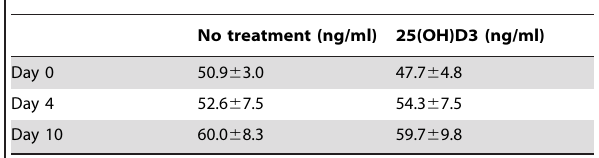
Table 1. Serum levels of 25(OH)D 3 in the cows treated with 100 ug 25(OH)D 3 infused into the mammary gland and cows